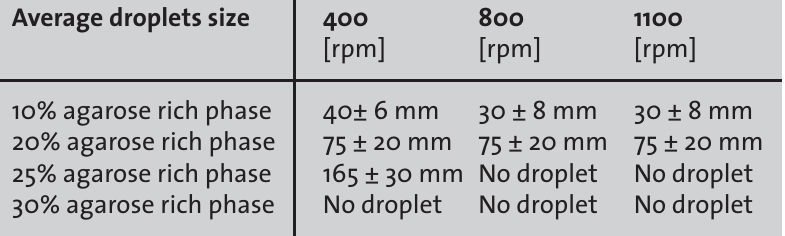
Table 1: Average diameter size for agarose rich phase droplets measured using a master- sizer. Figure 11 (above): Effect of mixing speed on large deformation behav- iour for maltodextrin/aga- rose composites obtained by mixing 80 % maltodextrin rich phase to 20 % agarose rich phase (shear rate: 0.05 s -1 , T : 10ºC). gel Figure 12 (below): Effect of phase volume and mixing speed on mechanical properties of maltodex- trin/agarose composites a) shear modulus b) shear fail- ure stress and c) shear fail- ure strain. The error bars are those estimated for the maltodextrin rich